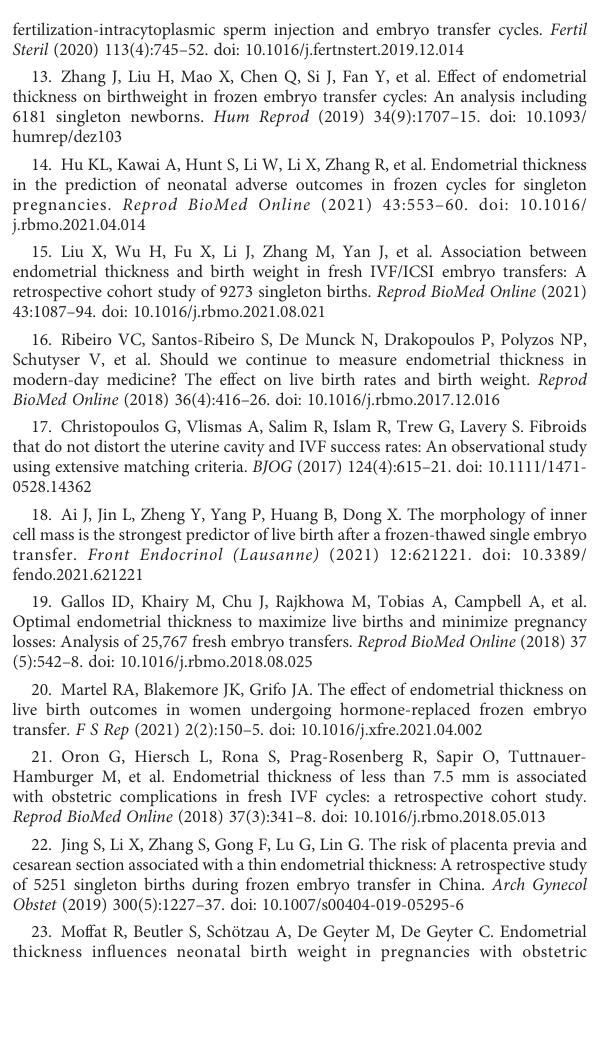
SUPPLEMENTARY FIGURE 1 Association analysis of EMT and clinical pregnancy/live birth. (A) Dose- responseassociationbetweenEMTandtheoddsofclinicalpregnancy; (B) Dose-response association between EMT and the odds of live birth; (C) ROC curve for EMT in the prediction of clinical pregnancy; (D) ROC curve for EMT in the prediction of live birth; (E) Forest plot of clinical pregnancy for women with different EMT; (F) Forest plot of live birth for women with different EMT. OR, odds ratio; EMT, endometrial thickness; AUC, area under the curve; REF,